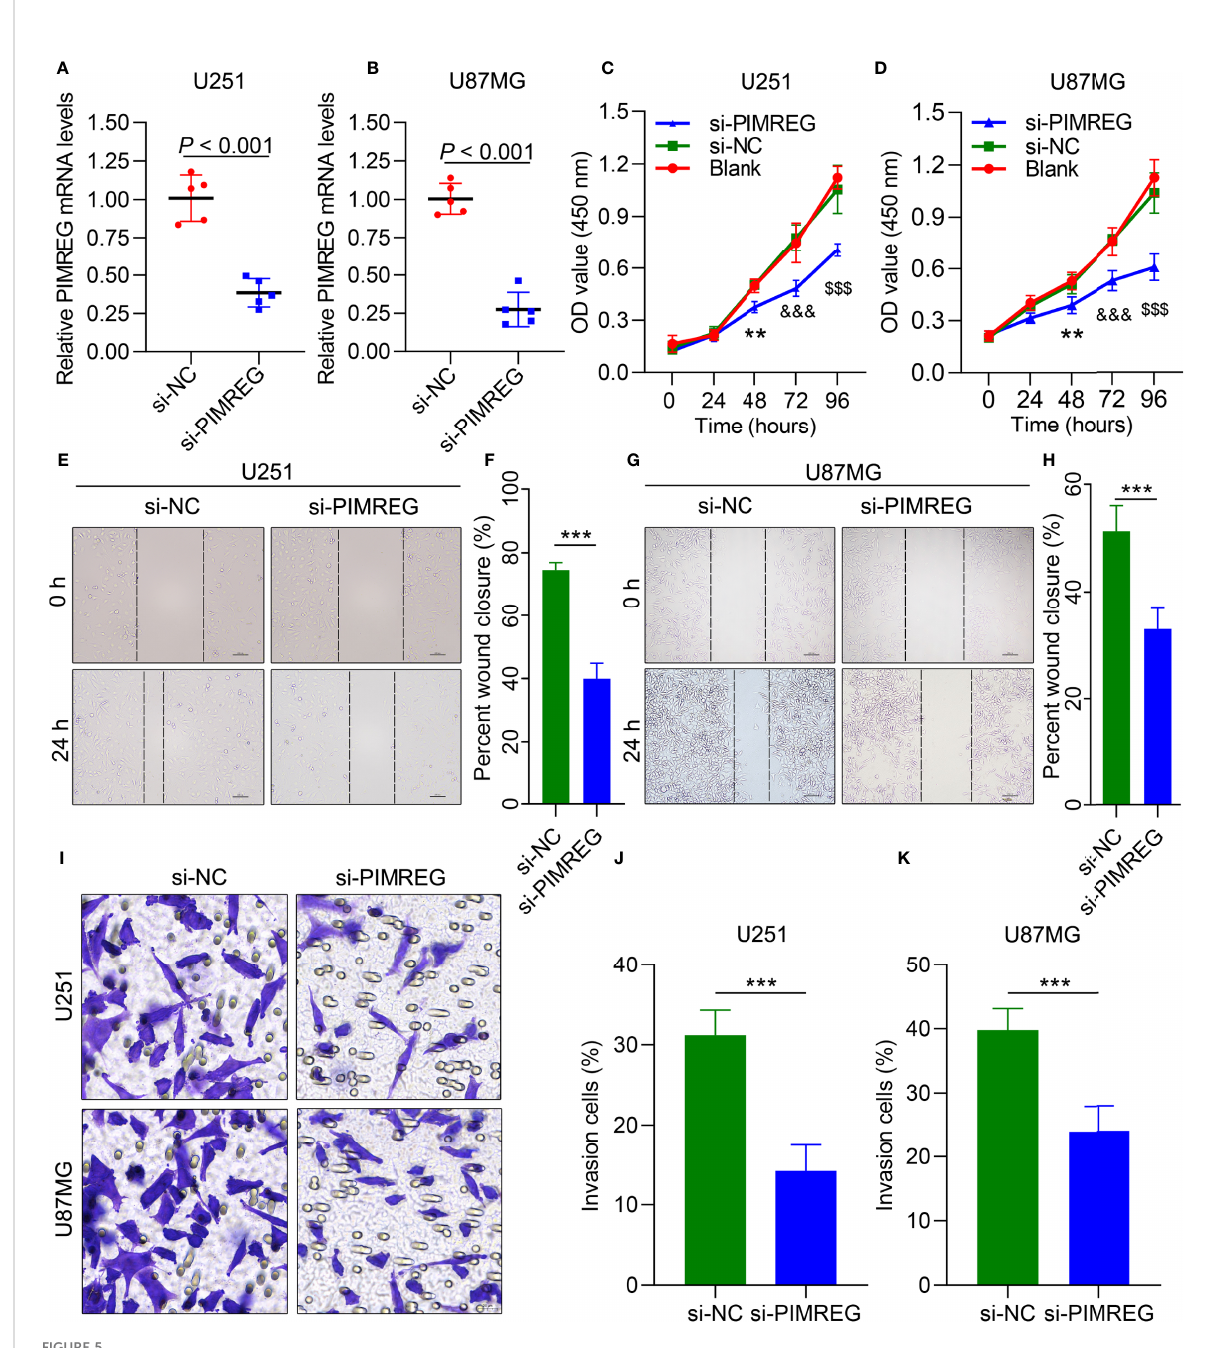
FIGURE 5 PIMREG enhances the migration and invasion of glioma cells in vitro . qRT – PCR results showing PIMREG expression in U251 (A) and U87MG (B) glioma cells after transfection. CCK-8 assays showing the viability of U251 (C) and U87 (D) cells. Wound healing was performed to determine the migration ability of U251 cells (E, F) and U87MG cells (G, H) . Transwell assays were performed to determine their invasion ability (I – K) . **P < 0.01; ***P < 0.001; $$$P < 0.001; &&&; P<